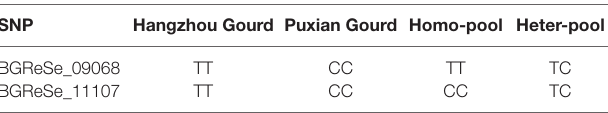
TaBle 3 | The genotypes of linked markers detected using the advanced BSA